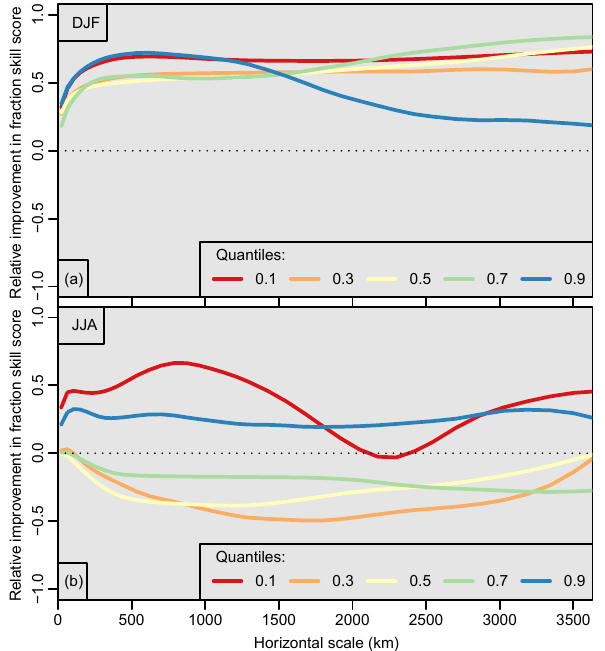
Figure 3. Relative improvement in the fractions skill score (FSS) of HadGEM3-GA3.0 N512 over N96 using E-OBS seasonal mean pre- cipitation as a reference, for (a) December–February and (b) June– August, and for different quantile thresholds of the spatial precipi- tation distribution in Europe ( − 14–50 ◦ E, 38–70 ◦ N).